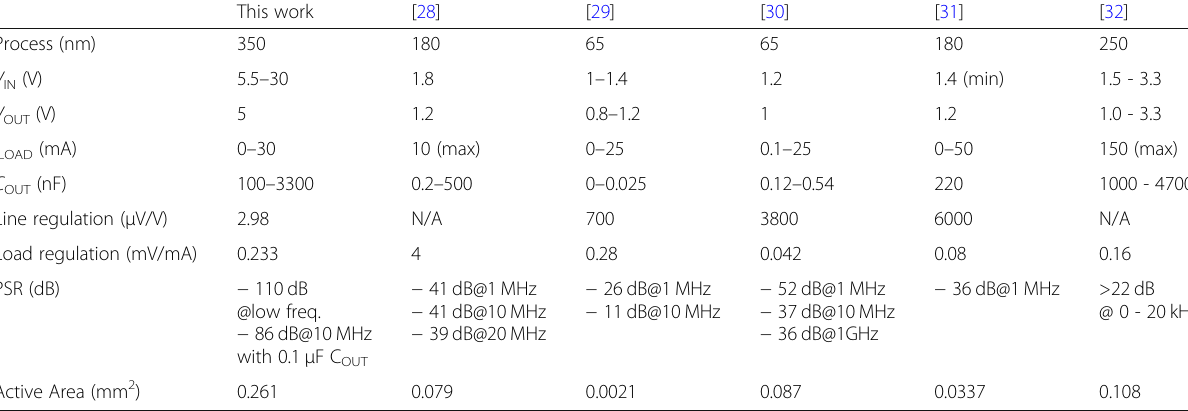
Table 1 Performance comparison of the proposed LDO with previously published LDOs This